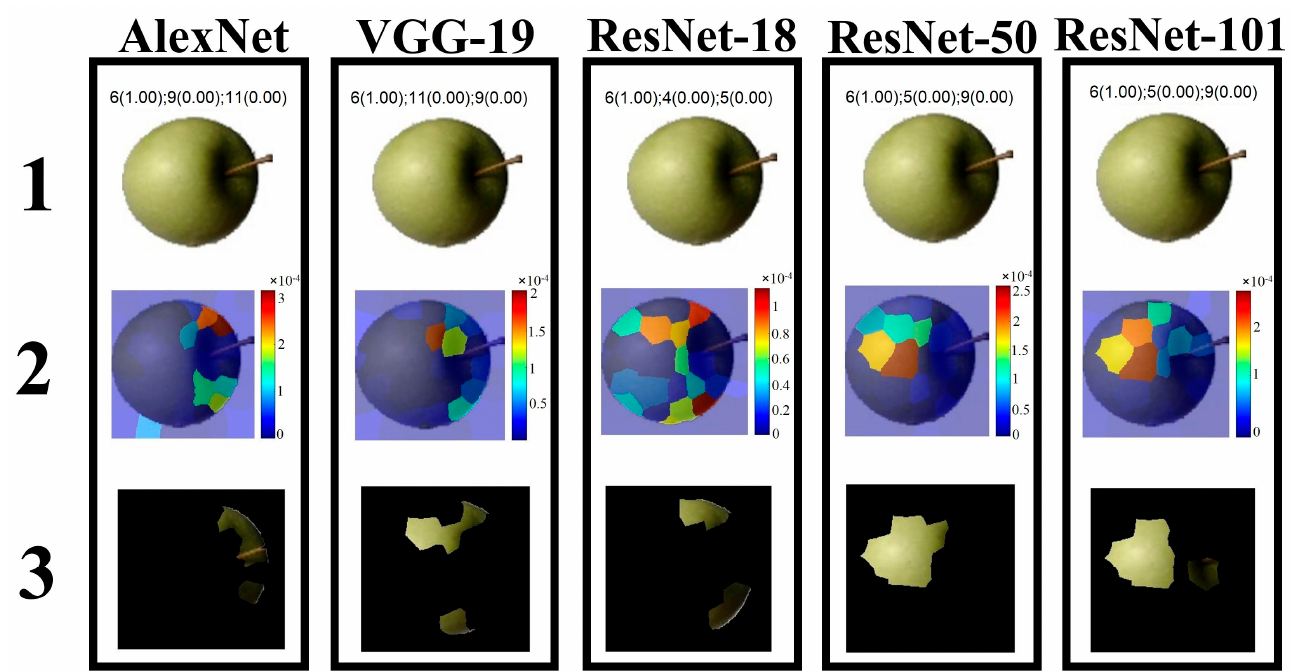
Figure 6. Understanding CNN-based models by using the LIME technique. The number on the image represents the corresponding row.